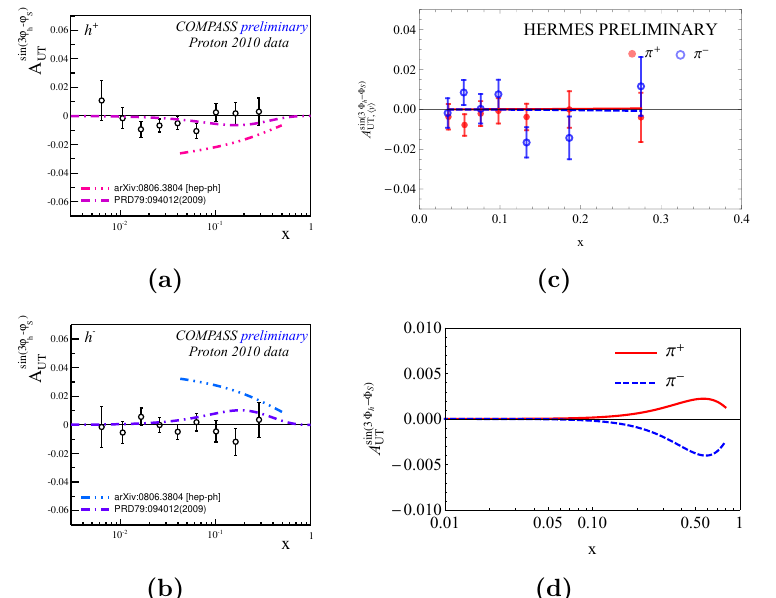
Figure 9. A sin(3 (cid:30) h (cid:0) (cid:30) S ) as a function of x from preliminary COMPASS [167] (a,b) and A sin(3 (cid:30) h (cid:0) (cid:30) S ) UT for HERMES [168] (c) in comparison to the best (cid:12)t from [169] (whose 1- (cid:27) uncertainty band